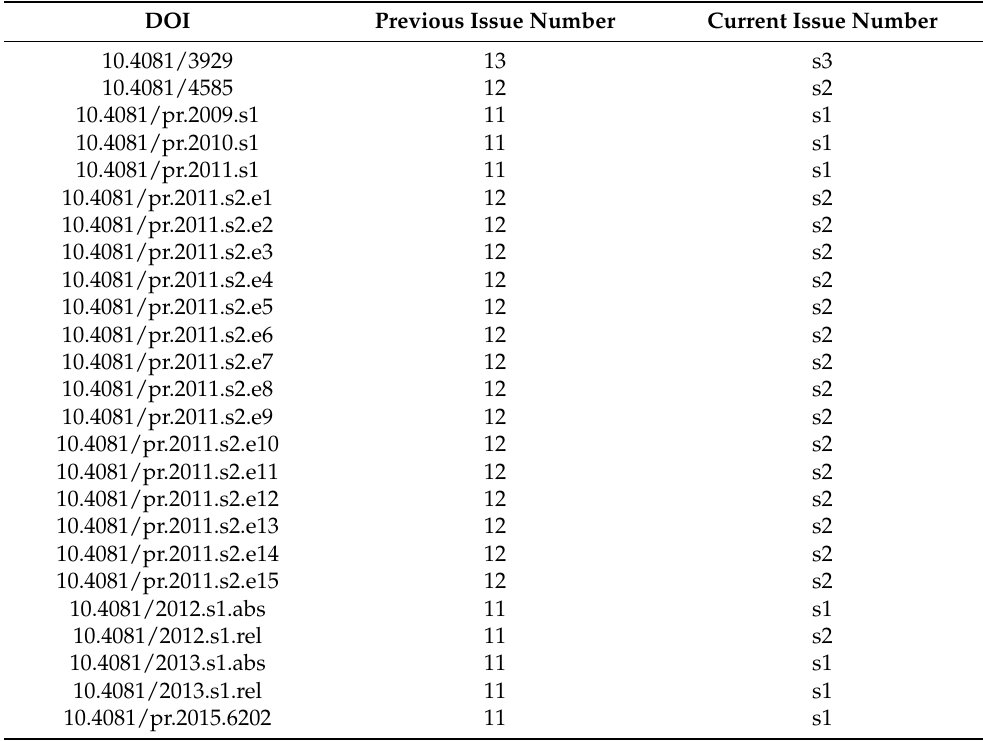
Table 2. MDPI corrected Issue numbers for 24 articles in Volumes 1–5 and